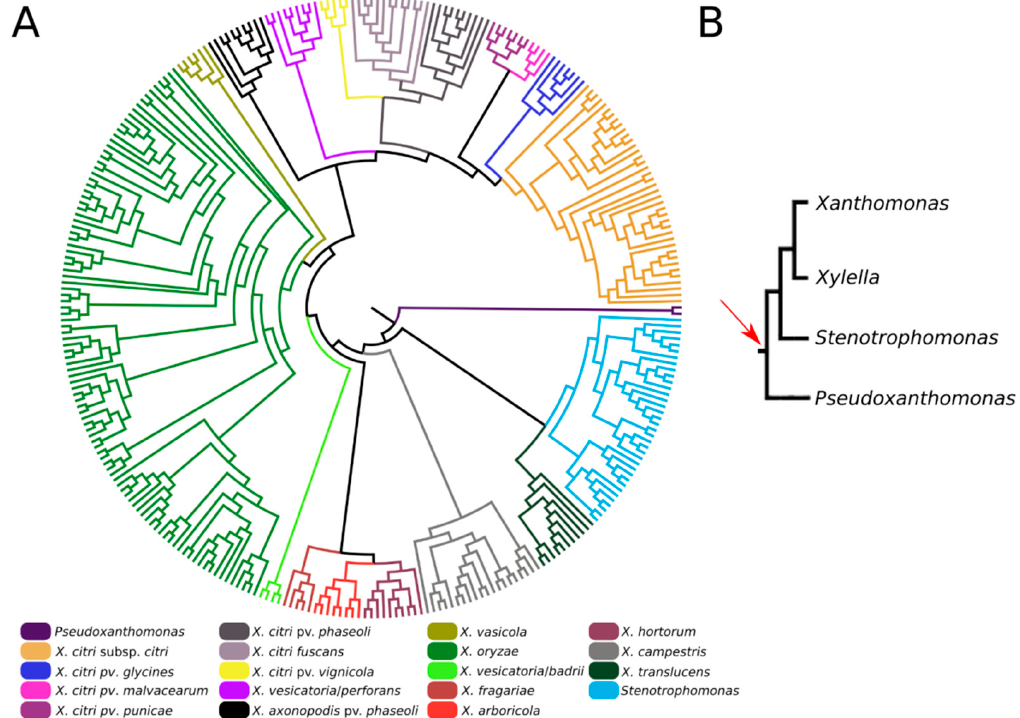
Figure 2. ( A ). Maximum-likelihood phylogenetic tree of XAC4296 homologs across the Xanthomonadaceae family supports the XAC4296 potential origin before Xanthomonas , Xylella , Pseudoxanthomonas , and Stenotrophomonas differentiation. The closely-related Xylella genus lost the XAC4296 homolog. ( B ). Phylogenetic construction of the Xanthomonadaceae family phylogroup formed by Xanthomonas , Xylella , Pseudoxanthomonas , and Stenotrophomonas (based on [41]). The red arrow indicates the potential gene fusion event that originated the XAC4296 ancestor.